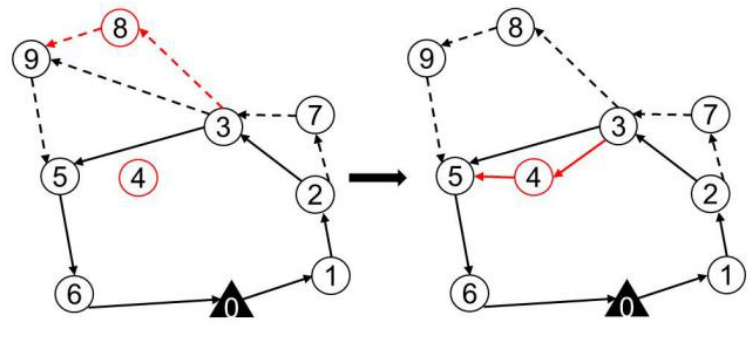
Figure 7. Schematic diagram of the greedy repair